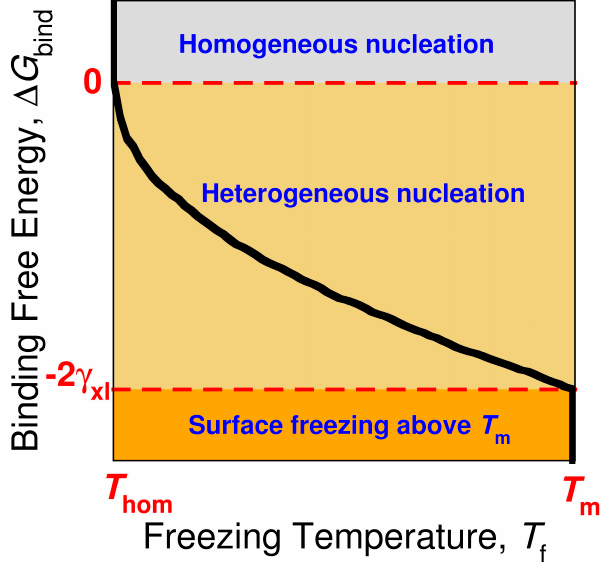
Figure 6. Sketch of the relation between the bulk freezing temperature T f of the alkane crystal (black line) and the binding free energy Δ G bind of the crystalline alkane to the nucleating surface. The curve corresponds to a constant nucleation rate, which determines the homogeneous nucleation temperature T hom [13]. The sign and magnitude of Δ G bind determines whether the surface can induce heterogeneous nucleation or promote surface freezing. If Δ G bind > 0, the crystal nucleates homogeneously at T hom . For surfaces that produce 0 > Δ G bind > − 2 γ xl , the nucleation of the alkane crystal is heterogeneous but there is no surface freezing above the equilibrium melting temperature T m . If Δ G bind < − 2 γ xl , the surface induces surface freezing of the alkane above T m , and the crystal nucleates heterogeneously from the frozen surface just below T m .